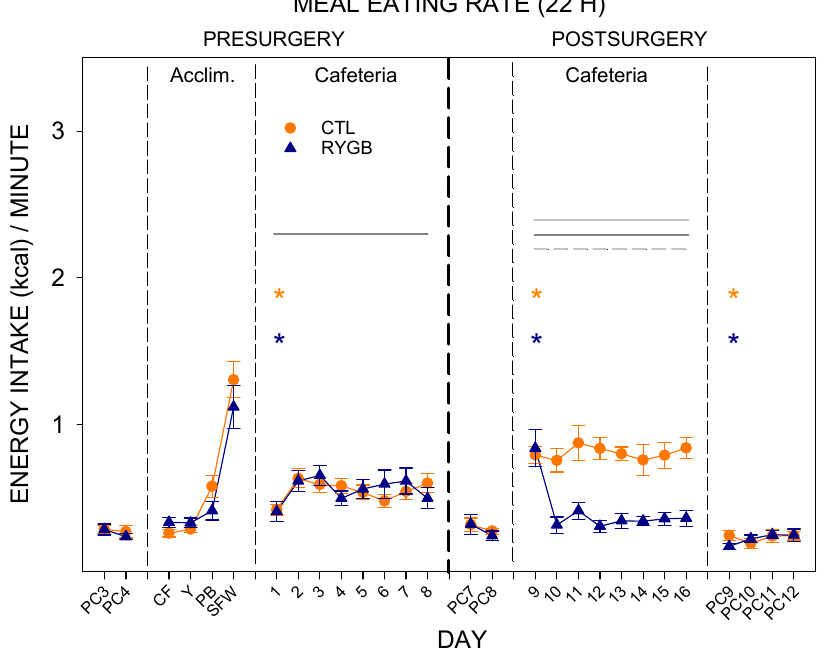
Figure 9. Meal Eating Rate across all 22-H Periods during Meal Pattern Monitoring. Mean (± SE) rate of consumption in kilocalories/minute for CTL (combined SHAM and IRON groups, n = 14; orange circles) and RYGB ( n = 11; blue triangles) rats for powdered chow days (PC), acclimation days for each food (Acclim.; CF: chickpea flour; Y: yogurt; PB: peanut butter; SFW: sugar/fat whip), and cafeteria diet days. Dashed vertical lines indicate transitions between diet conditions (thin dashed) and between pre- and post-surgical phases (thick dashed). Statistically significant results from two-way mixed ANOVAs (Table 10) are indicated by horizontal lines: Gray solid (group), dark gray solid (day), or gray dashed (group × day interaction). *: Statistically significant result of a paired t -test (Table 11) for the group indicated by color, comparing the marked day to the previous day. Table 10. Two-way ANOVAs Comparing 22-H Meal Eating Rate between Groups for Each Diet Condition.